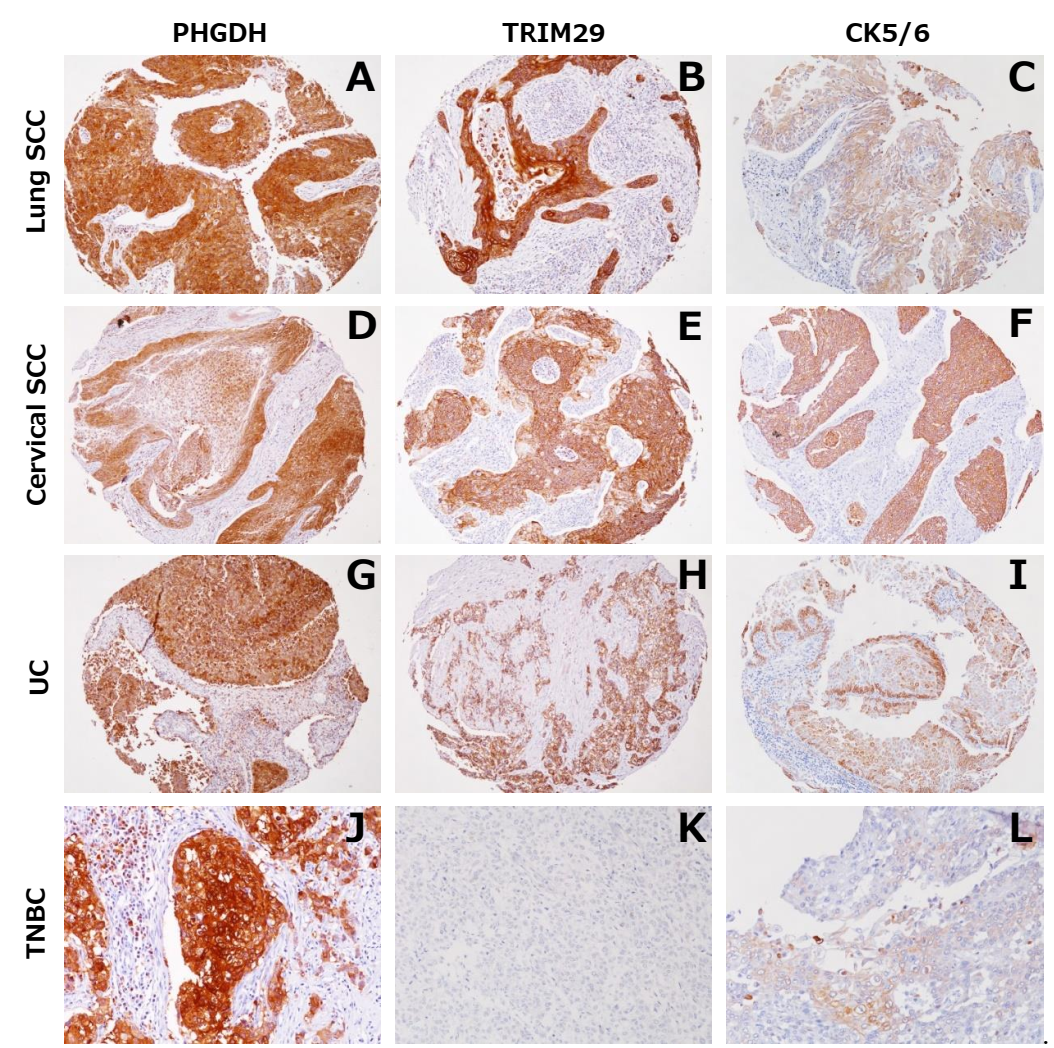
Figure 4. Immunohistochemical staining for PHGDH and TRIM29 in tumors other than MM in TMA. Representative immunohistochemical staining patterns in tumor samples for PHGDH ( A , D , G , J ), TRIM29 ( B , E , H , K ) and CK5/6 ( C , F , I , L ). PHGDH, TRIM29 and CK5/6 were occasionally detected in squamous cell carcinoma of the lung ( A – C ), squamous cell carcinoma of the uterine cervix ( D – F ) and urothelial carcinoma ( G – I ). PHGDH and CK5/6 were expressed significantly in triple-negative invasive ductal carcinoma, while TRIM29 was not (TNBC; J – L ). PHGDH and TRIM29 were occasionally detected in the normal squamous epithelium of the uterine cervix, prostate basal cells, bronchial basal cells and mesothelial cells, which are also positive for CK5/6 (Supplementary Figure